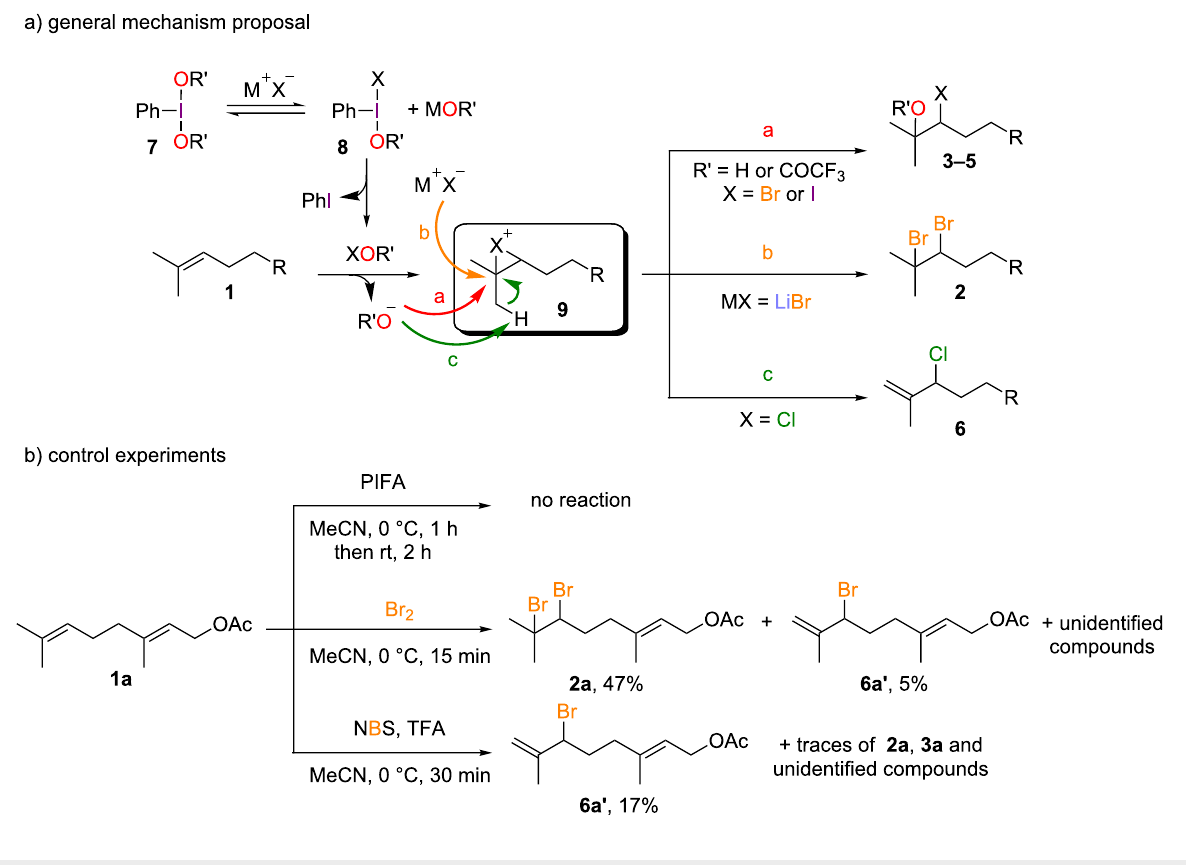
Scheme 7: General mechanism proposal for the formation of 2 – 6 and control experiments.